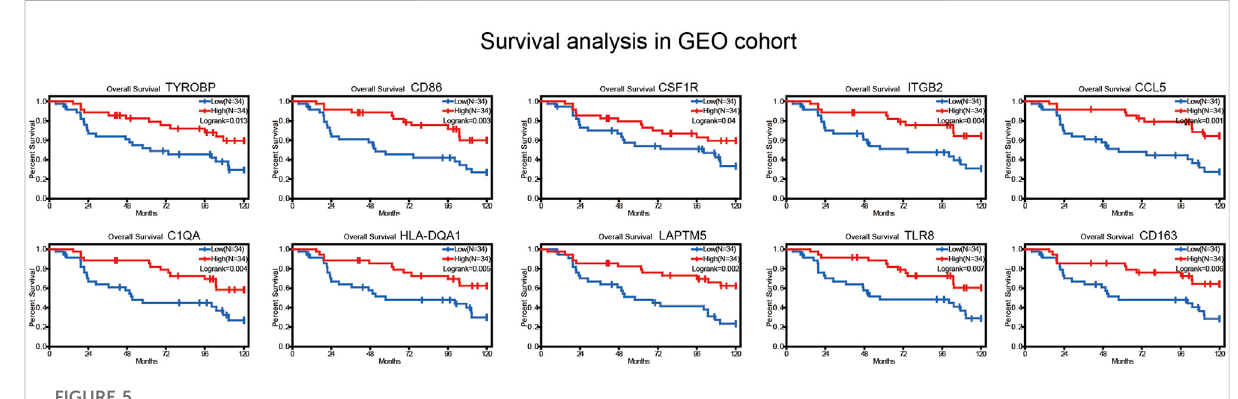
FIGURE 5 Survival curves for immune-related genes in GEO